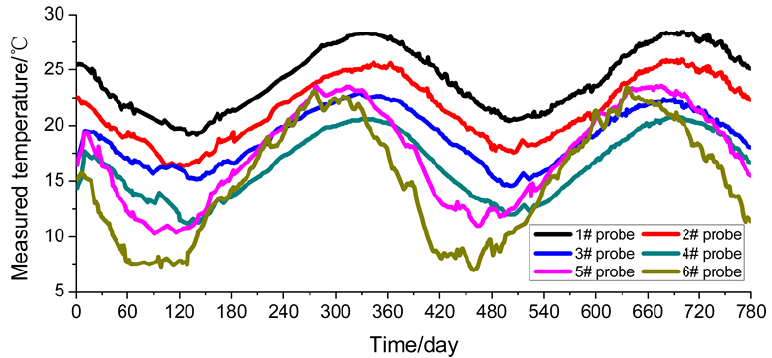
Figure 8. Temperature measured by FDR sensors.